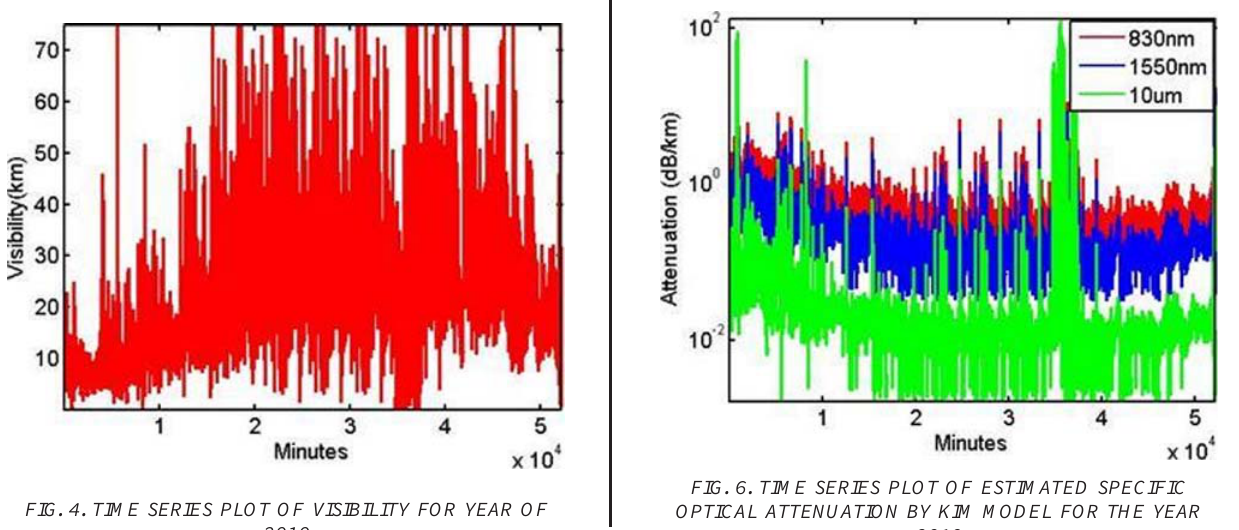
FIG. 4. TIME SERIES PLOT OF VISIBILITY FOR YEAR OF 2010